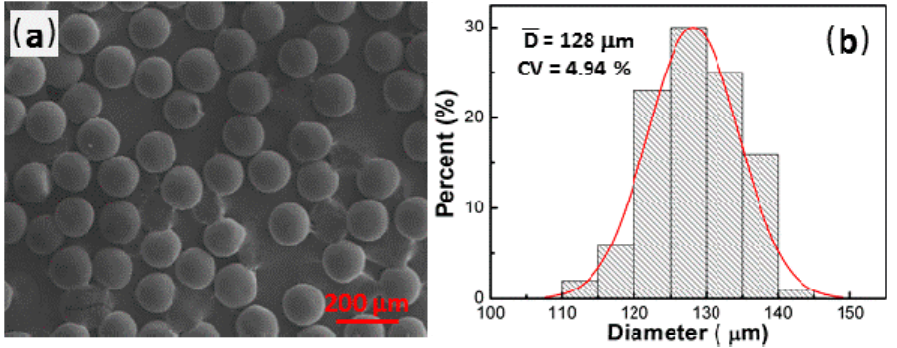
Figure 5. ( a ) Scanning electron microscopy (SEM) micrographs of RF microspheres; ( b ) particle size distribution of microspheres. Curing conditions: T 1 = 90 °C, t 1 = 20 min; T 2 = 110 °C, t 2 = 30 min.